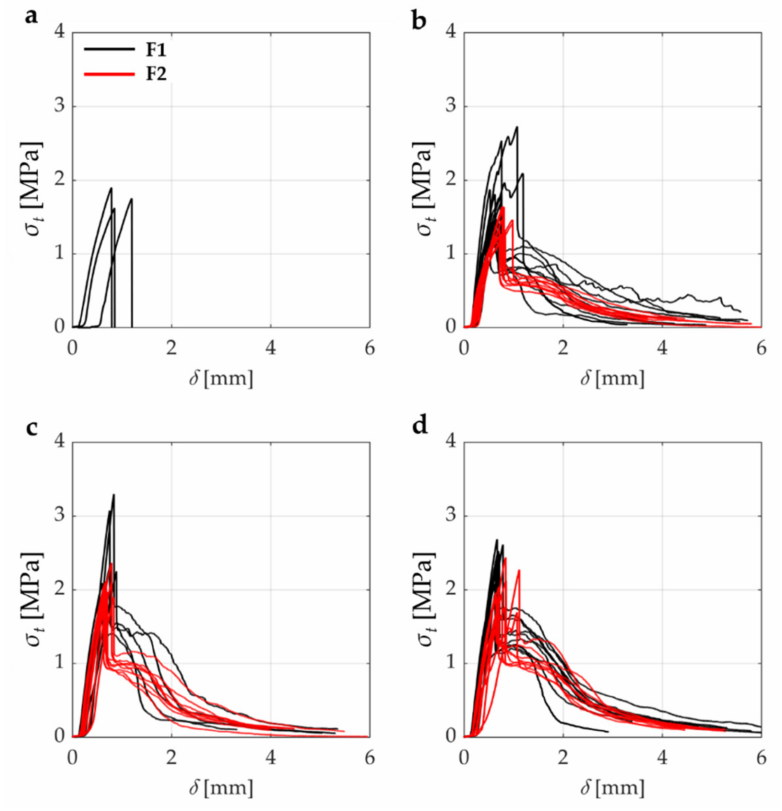
Figure 15. Tensile stress σ t vs. vertical displacement in the BTs for: ( a ) Un-strengthened case (UR). Strengthened cases with two fiber types, F1 and F2, and three fiber contents, F : ( b ) 0.6%; ( c ) 0.75%; ( d )